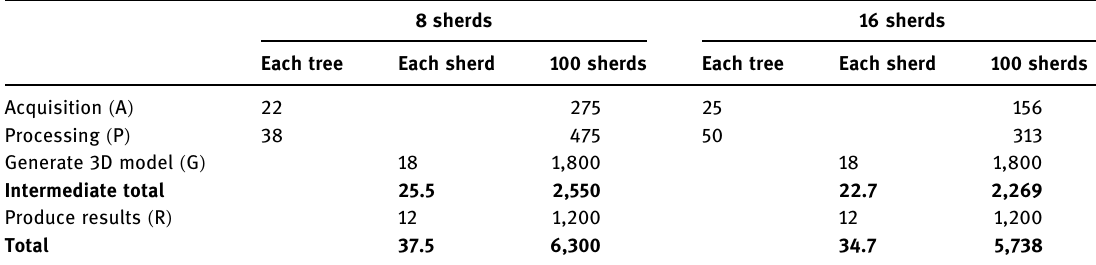
Table 2: Duration of individual processing steps in